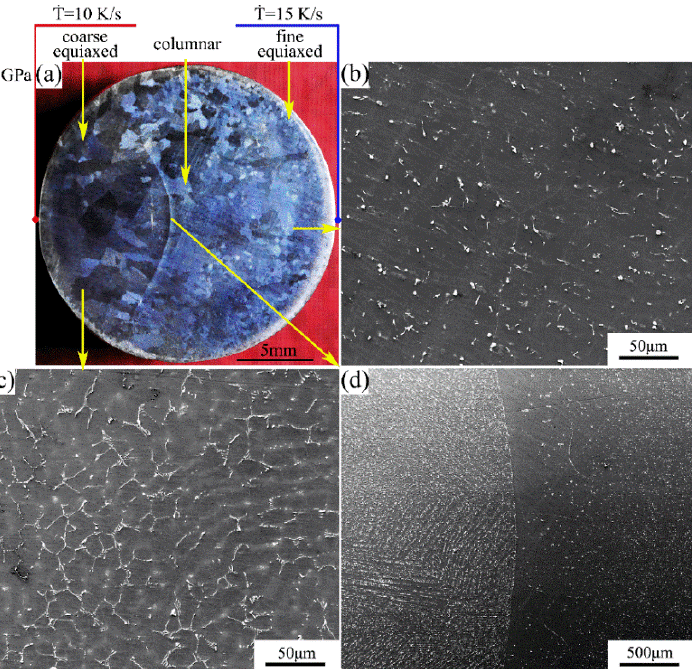
Figure 5. ( a ) Macrostructure and ( b – d ) microstructure of the Mg-1Sn-2.5Y alloy solidified under a pressure of 1 GPa: ( b ) outer fine equiaxed zone; ( c ) coarse equiaxed zone; ( d ) columnar-to-equiaxed transition zone.